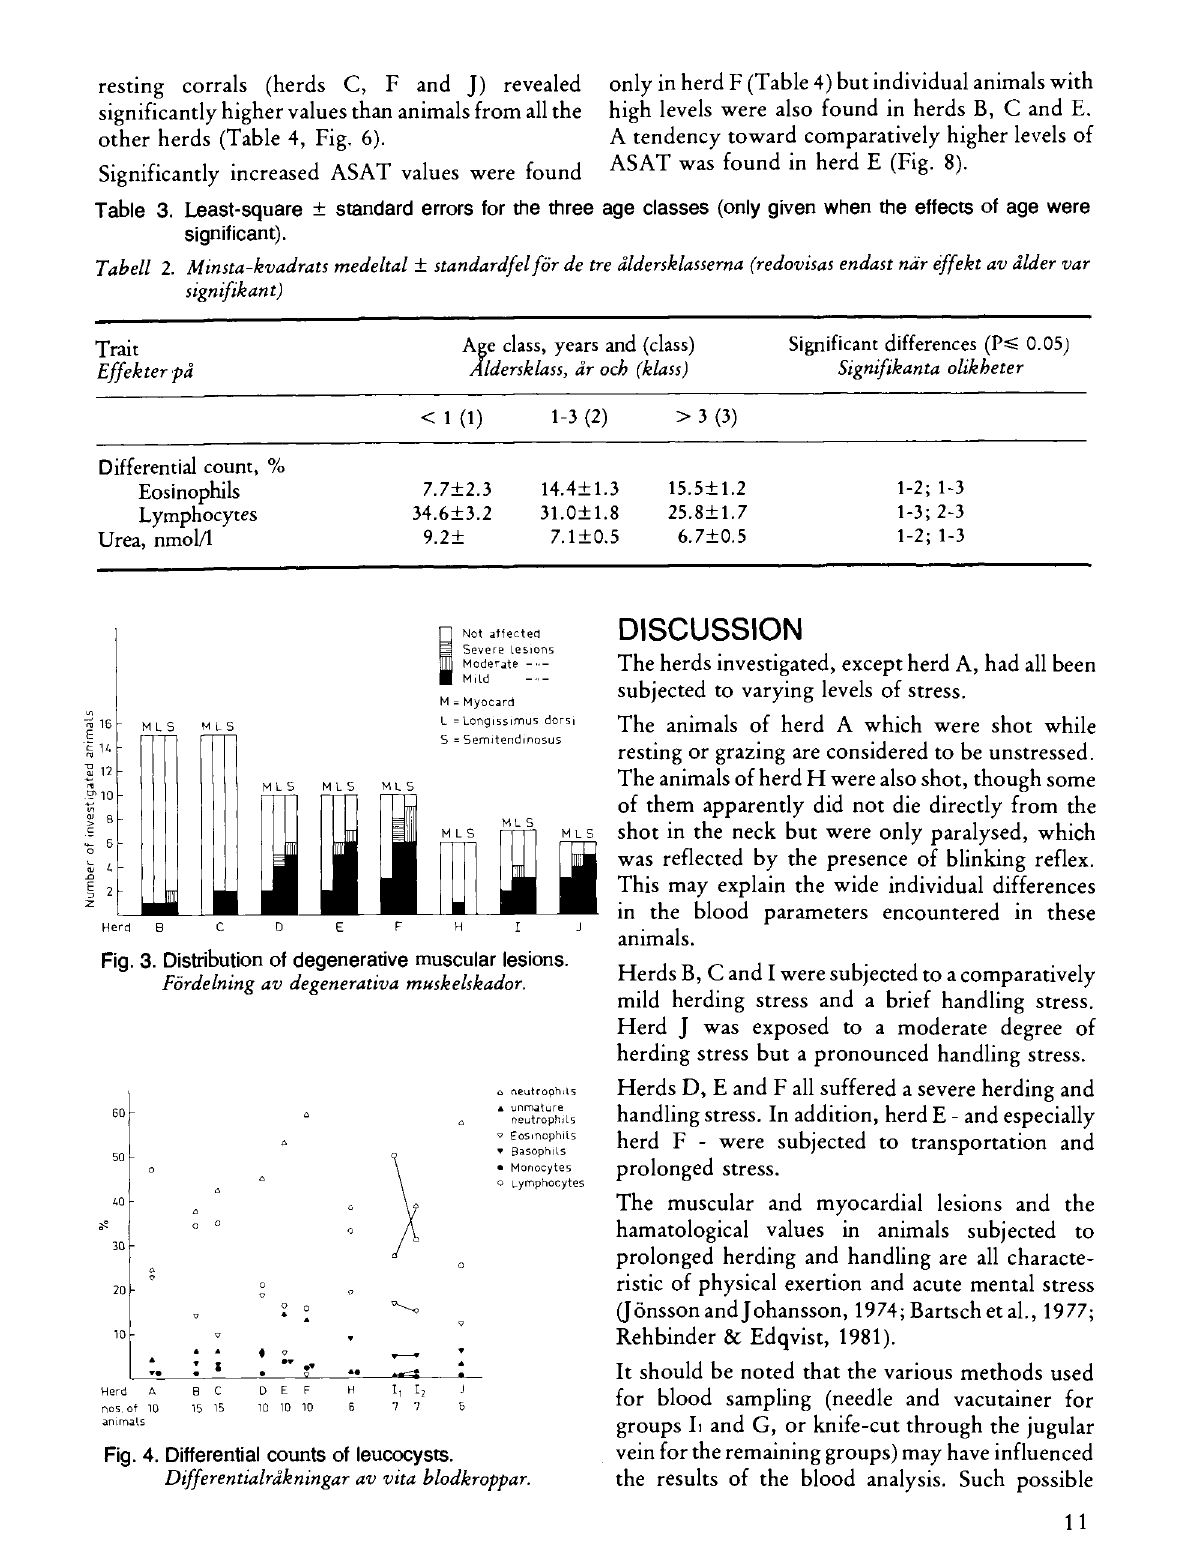
Fig. 4. Differential counts of leucocysts. Differentialrdkningar av vita